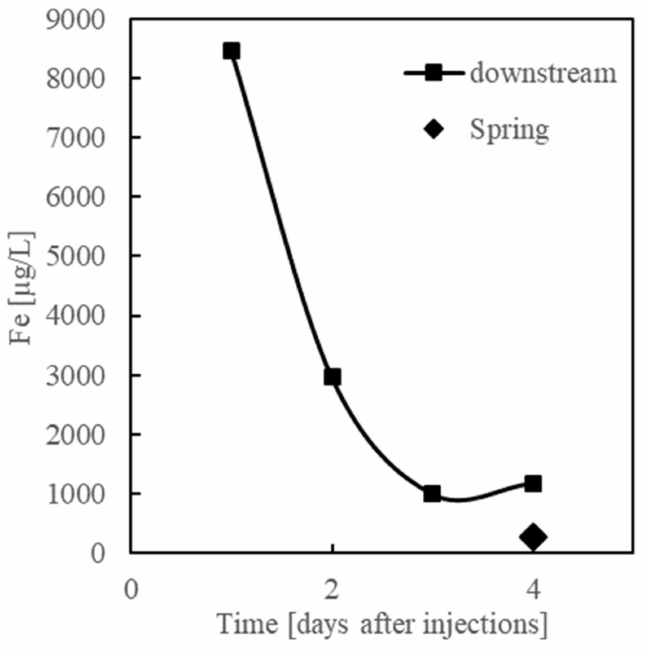
Figure 5. Observed iron concentrations in groundwater samples taken from the downstream